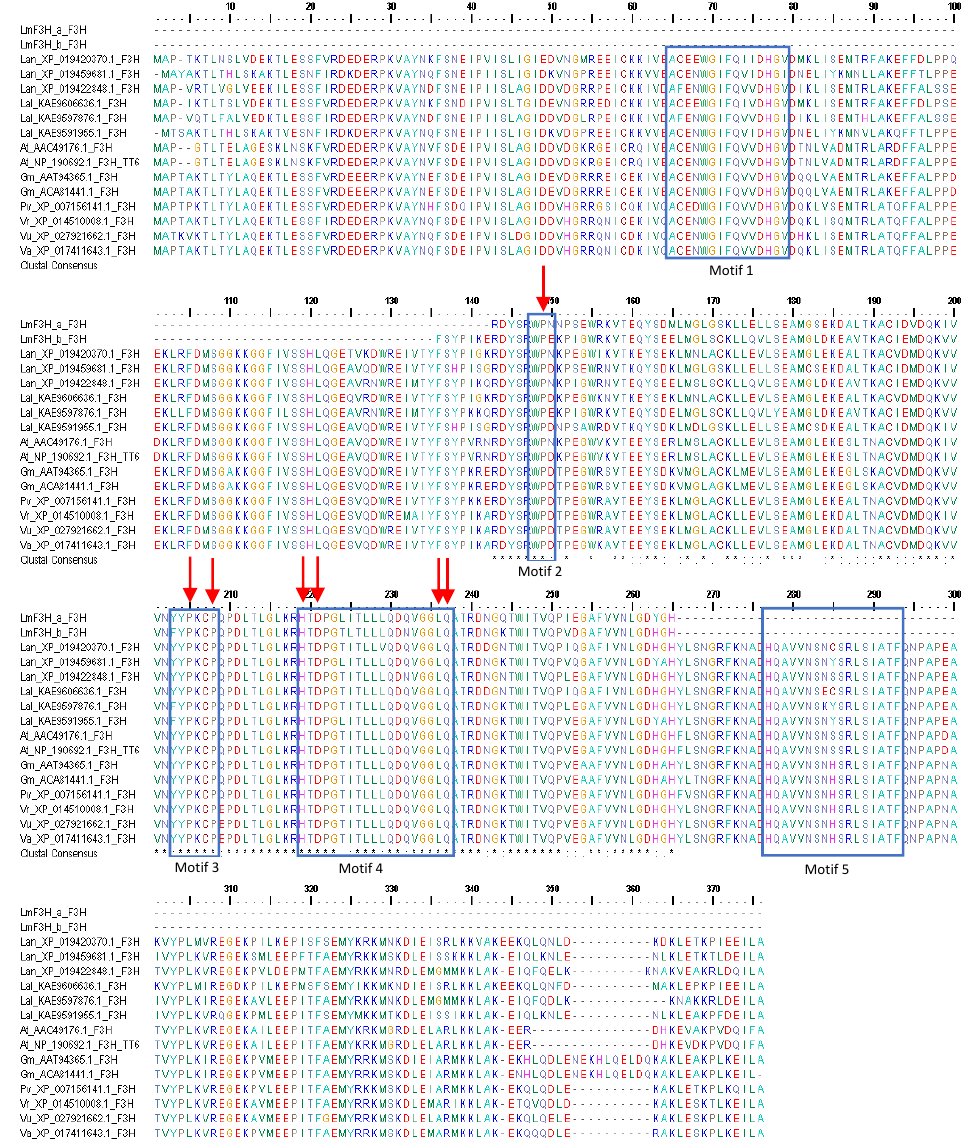
Figure 6. Alignment of the Lupinus mutabilis LmF3H_a and LMF3H_b protein fragments with other F3H proteins showing the conserved nature of the tarwi sequences. The five motifs specific of these proteins are outlined. Arrows indicate the strictly conserved amino acids present in the tarwi fragments. At— Arabidopsis thaliana ; Gm— Glycine max ; Lal— Lupinus albus ; Lan— L. angustifolius ; Pv— Phaseolus vulgaris ; Vr— Vigna radiata ; Vu— V. unguiculata .